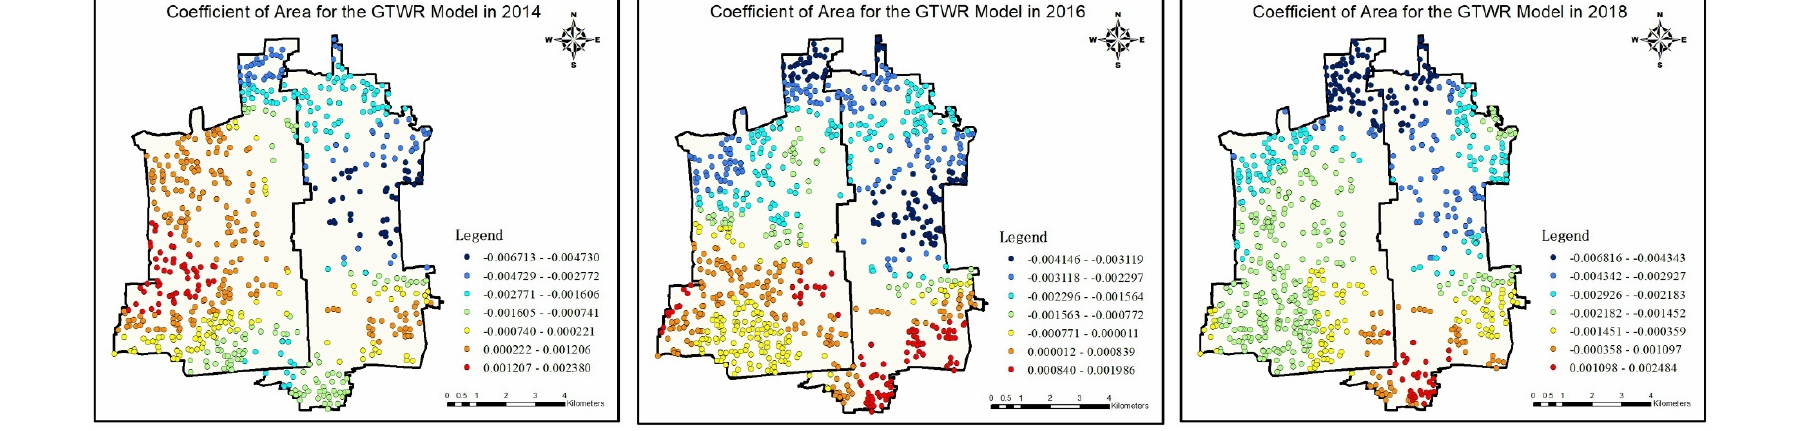
Figure 5. Coefficient of area for the GTWR model in 2014, 2016, and 2018.